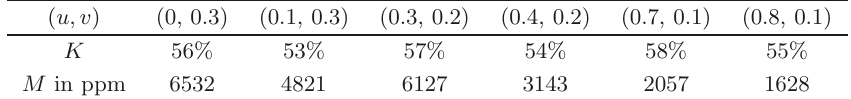
Table 2. Pairs ( u, v ) for which K is roughly equal to 57% when C (cid:2)(cid:2) p ( u, v ) = 1, and M the maximum percentage of non-